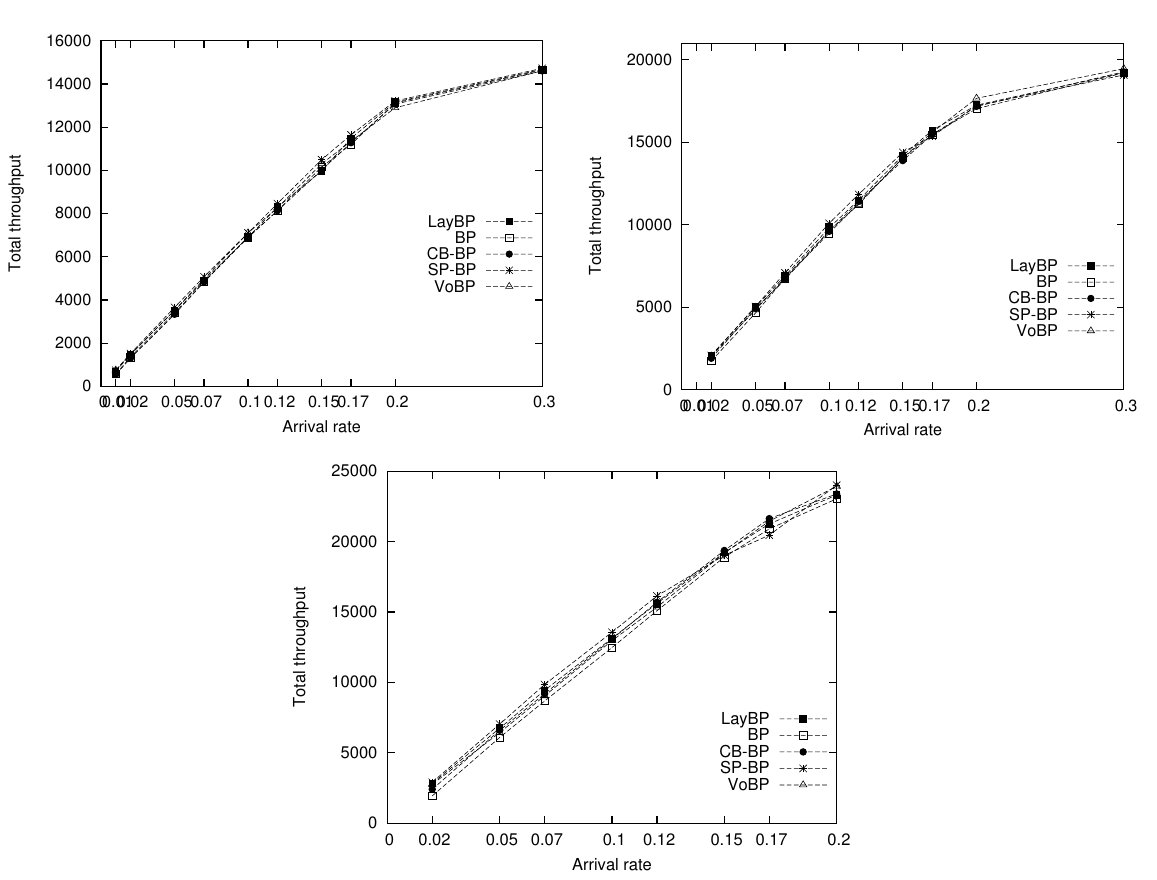
Figure 8. Throughput performance for the three network topologies ( 16 , 22 and 30